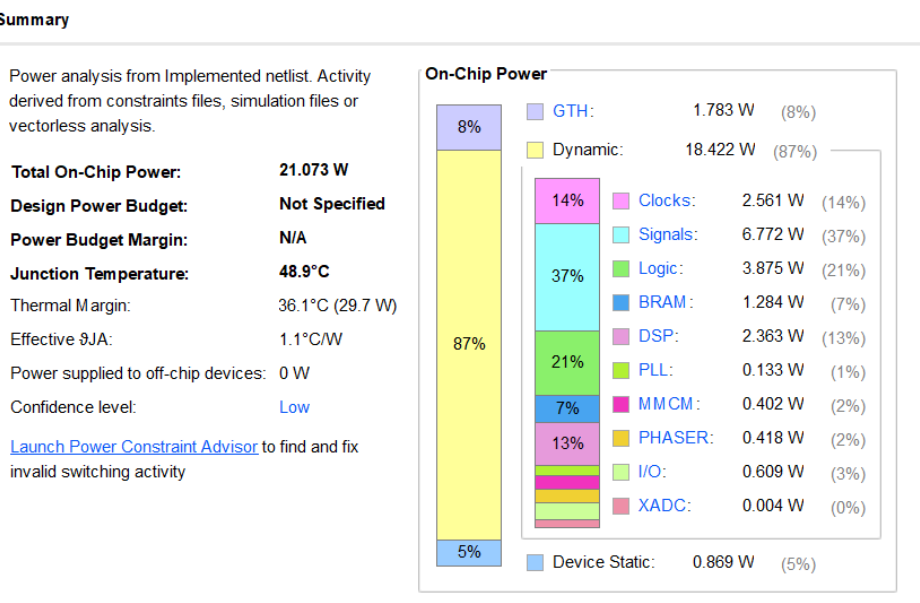
Figure 17. Vivado power analysis.